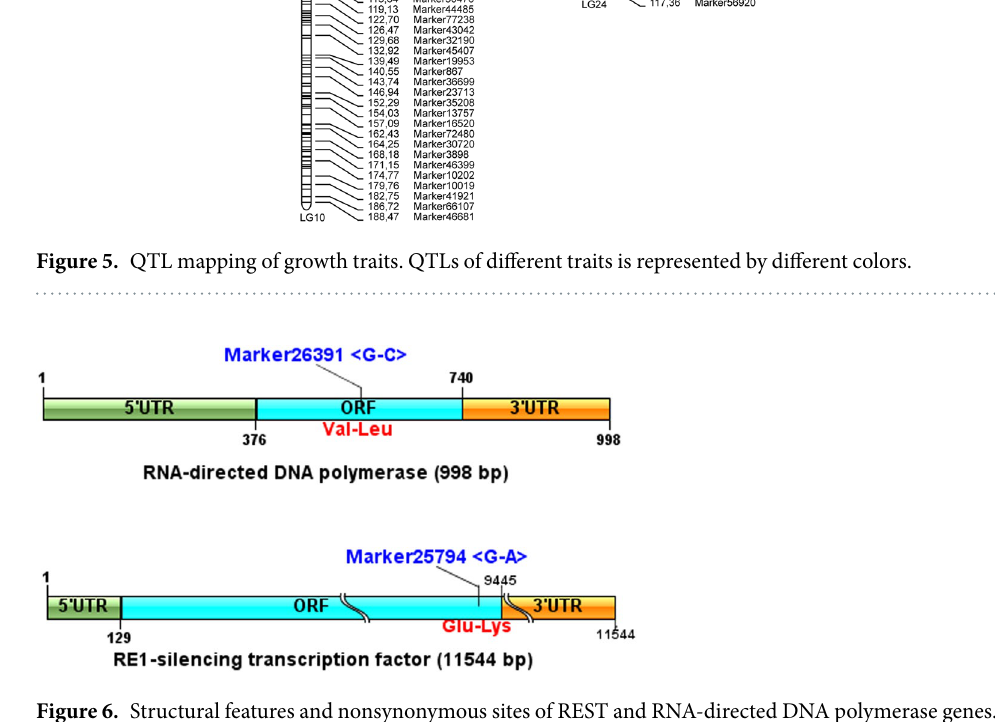
Figure 6. Structural features and nonsynonymous sites of REST and RNA-directed DNA polymerase genes. cDNA sequences of two genes were assembled based on transcriptome unigene data. Marker26391 with a SNP (G–C) on RNA-directed DNA polymerase led to the nonsynonymous change of Val to Leu; Marker25794 with a SNP (G–A) on REST led to the nonsynonymous change of Glu to